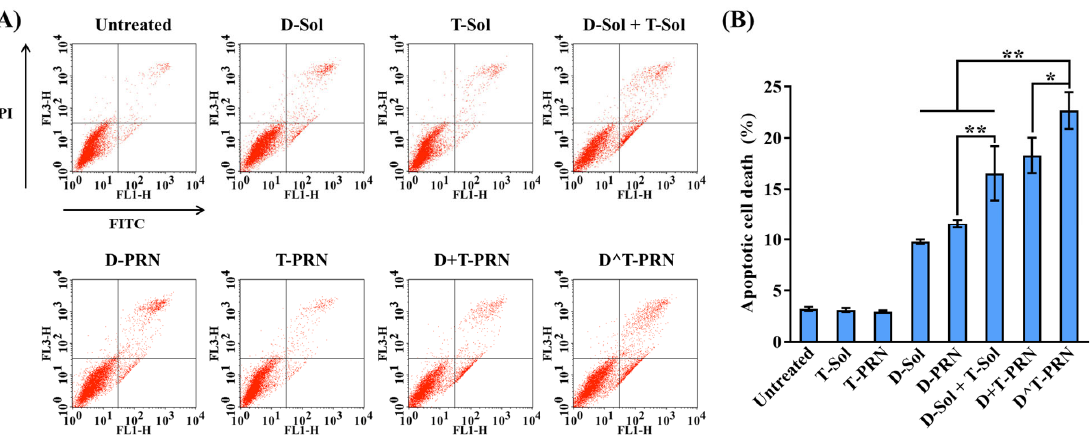
Figure 5. Induction of apoptosis in MCF7/ADR cells following 24 h treatment with docetaxel (DTX)- and/or tariquidar (TRQ)-loaded formulations at a 10 ng/mL DTX-equivalent concentration. ( A ) Scatter plots and ( B ) quantitative cells; top right (Q2, FITC+/PI+), late apoptotic cells; bottom left (Q3, FITC–/PI–), live cells; and bottom right (Q4, FITC+/PI–), early apoptotic cells. Data represent mean ± standard deviation (SD) ( n = 3). The differences were significant at * p < 0.005 and ** p <